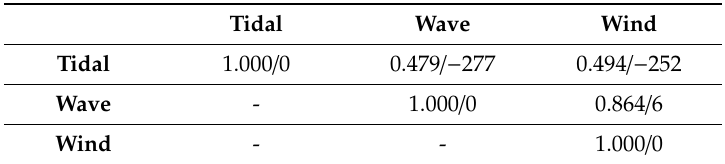
Table 2. Peak cross-correlation coe ffi cient (xR) and the associated lag (xL(hrs)) at which it occurs between generation profiles. Data is presented in the table in the form: xR / xL, where xL is positive when the signal on the left of the table lags the signal above. Cross-correlations associated with a lag of more than 24 h are thought to lack physical meaning.